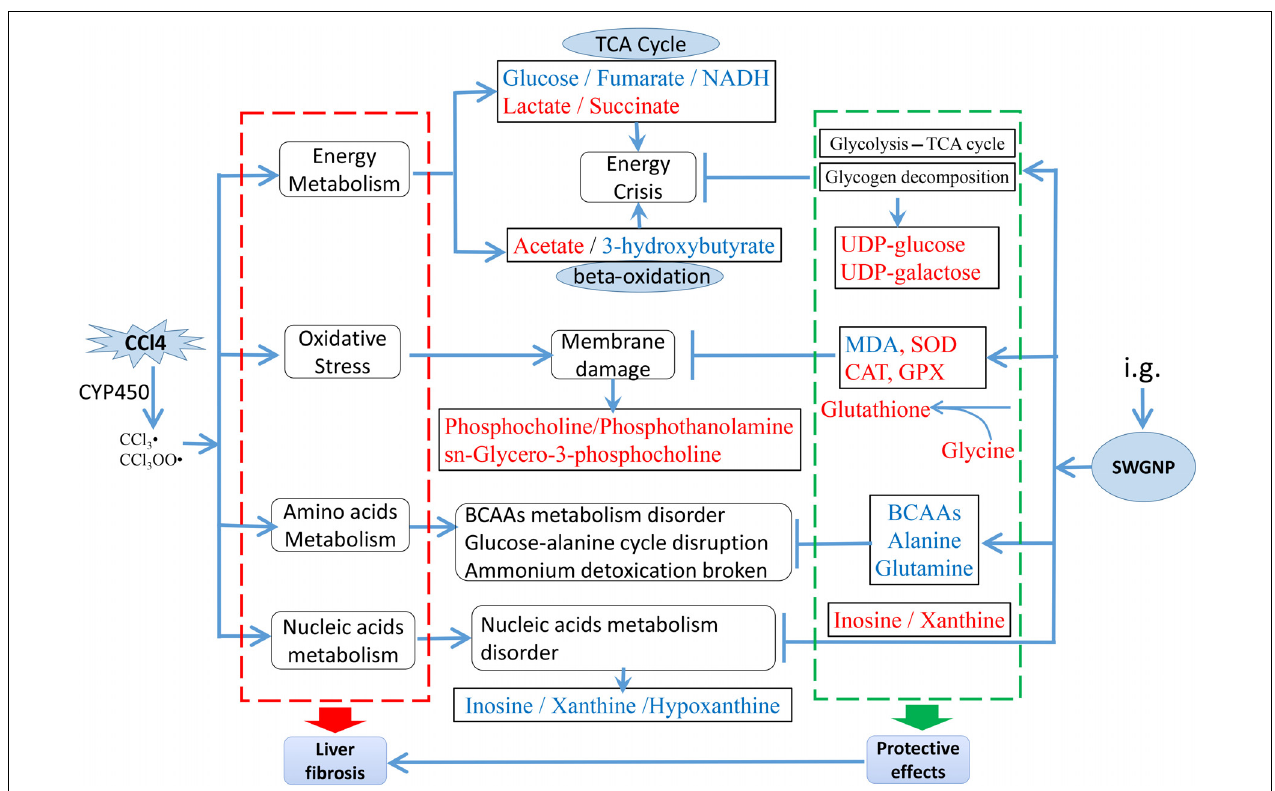
FIGURE 10 | The main metabolic pathways in response to CCl 4 induced liver fibrosis and the treatment effects of SWGNP, showing the interrelationship of the identified metabolic pathways. Metabolites in red and blue color represent significantly increase or